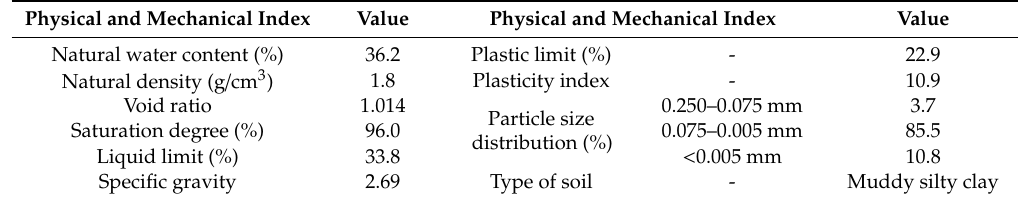
Table 1. Physical indexes of